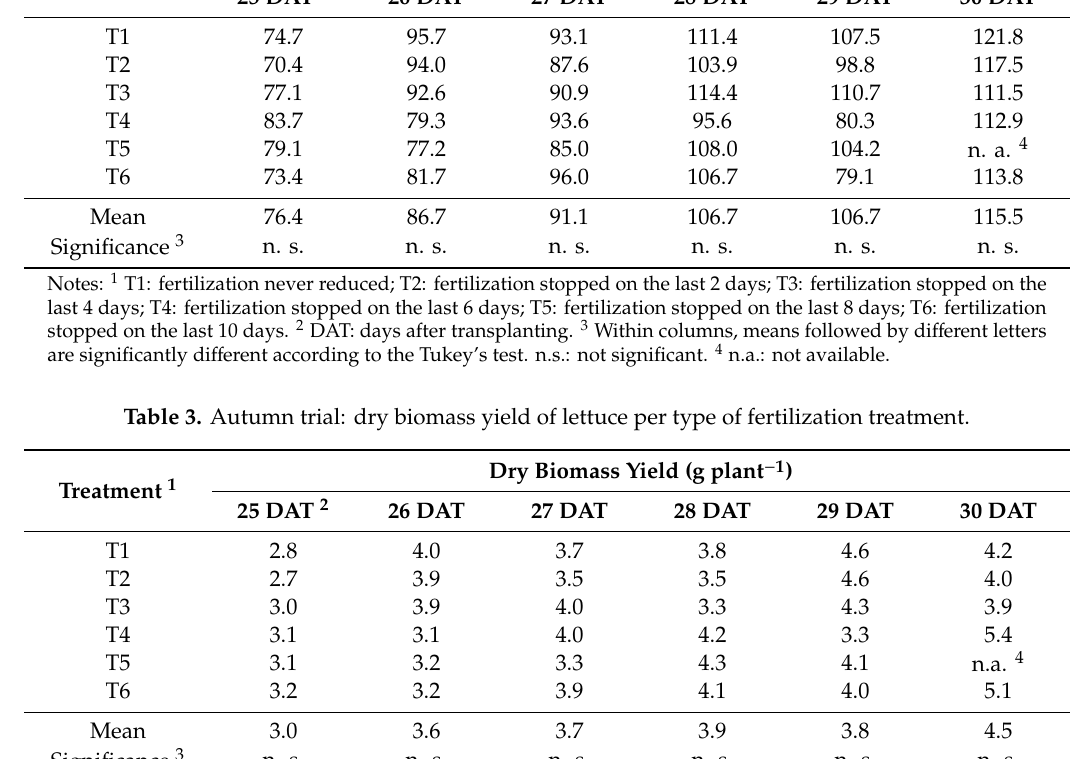
Table 2. Autumn trial: fresh biomass yield of lettuce per type of fertilization treatment. Treatment 1